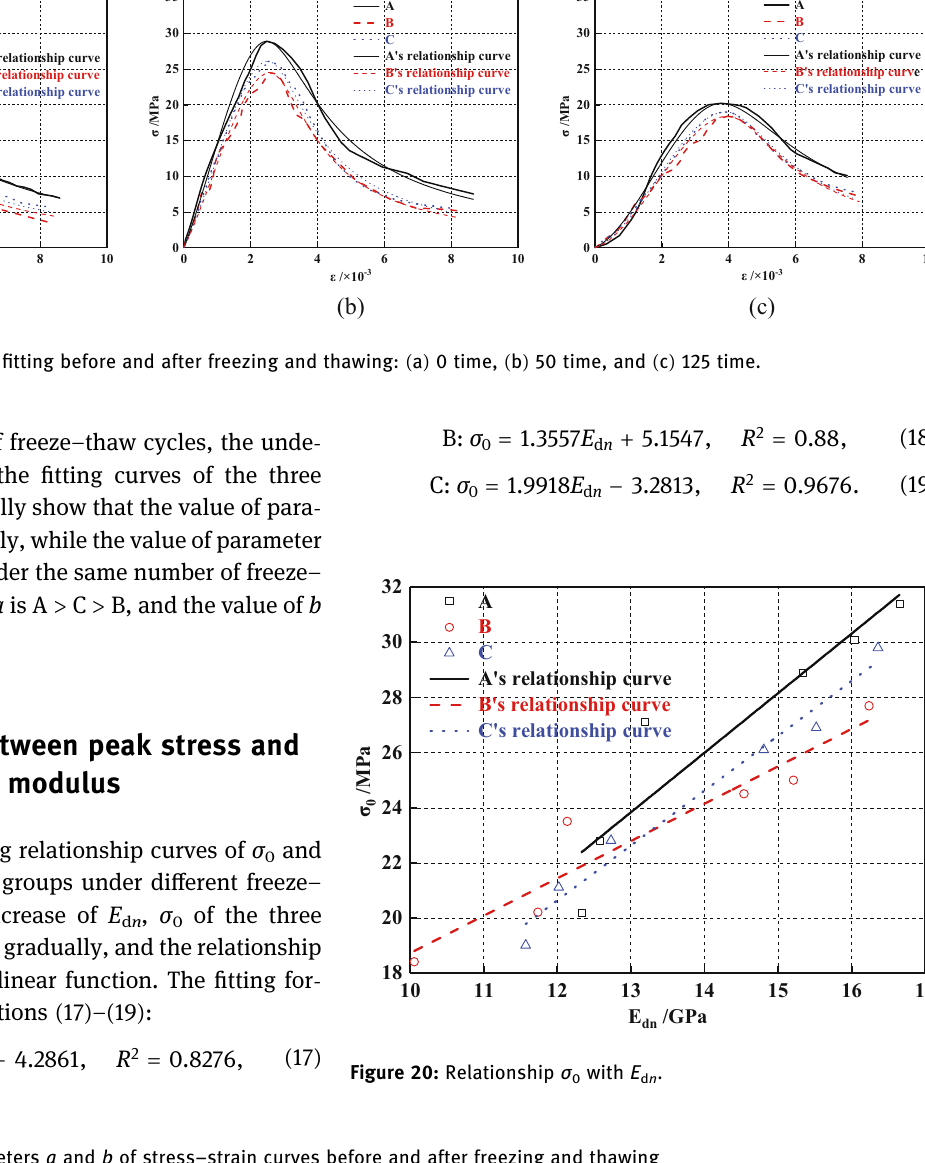
Table 4: Undetermined parameters a and b of stress – strain curves before and after freezing and thawing